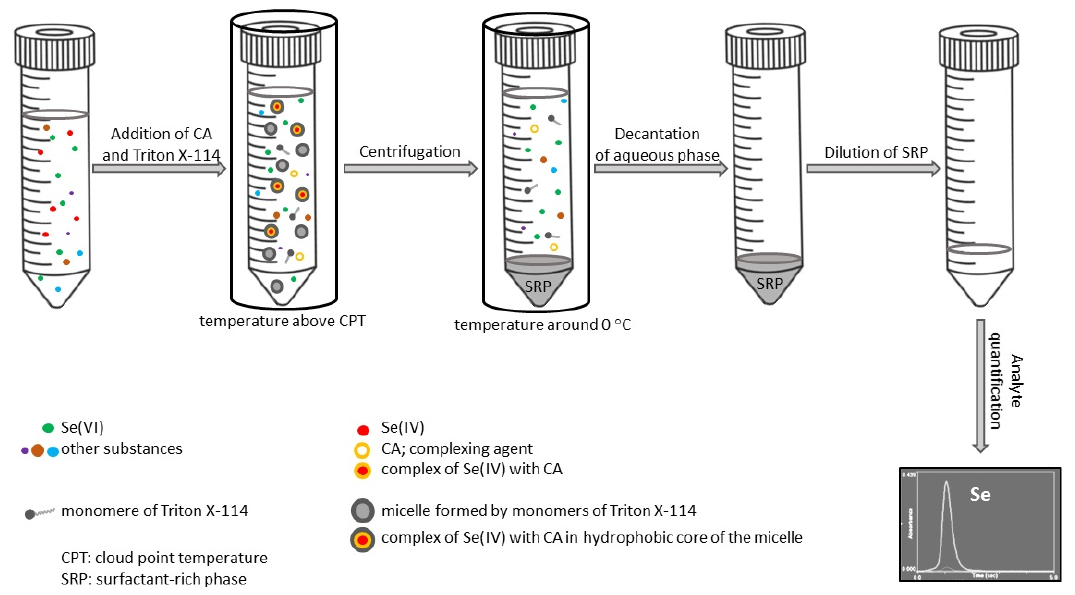
Figure 2. Schematic illustration of cloud point extraction steps for selective separation and precon- centration of Se(IV). Se, selenium.